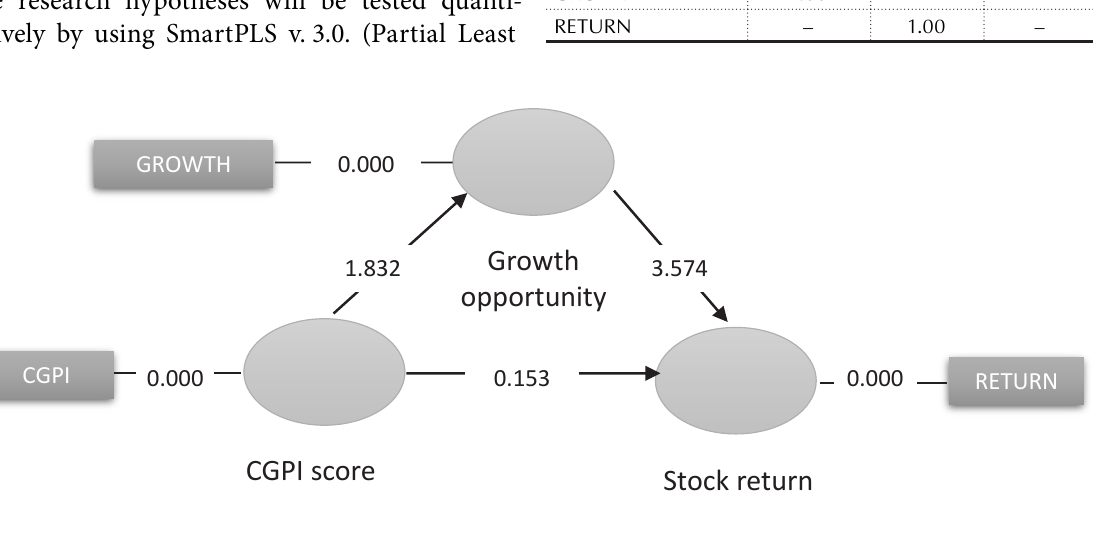
Figure 3. Bootstrapping output